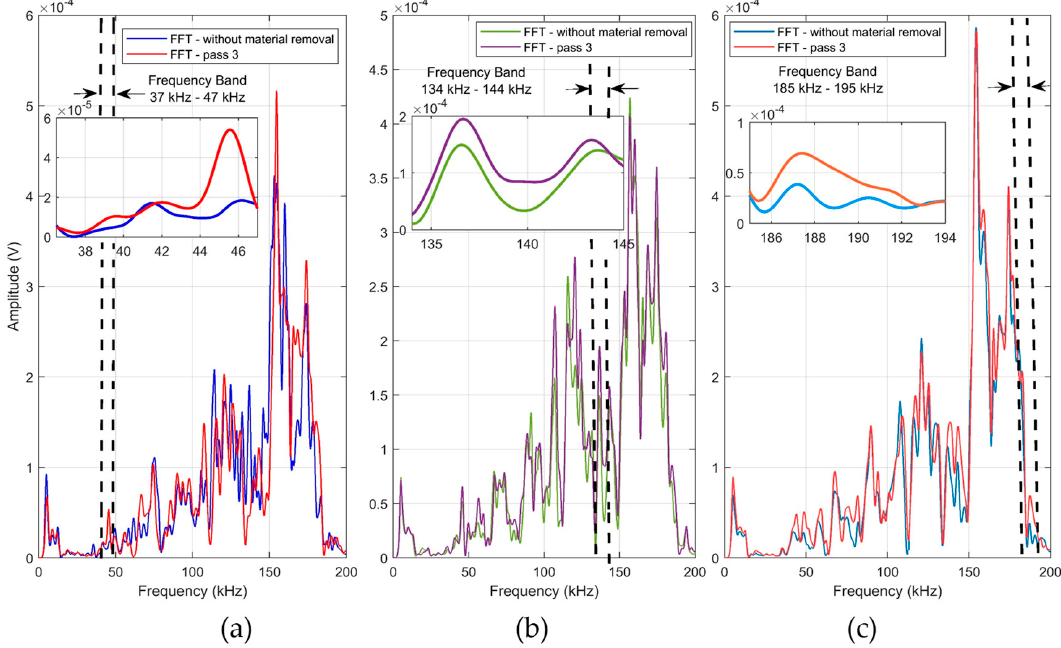
Figure 10. Spectrum of two workpiece conditions at ( a ) 10 µm, ( b ) 20 µm and ( c ) 30 µm.